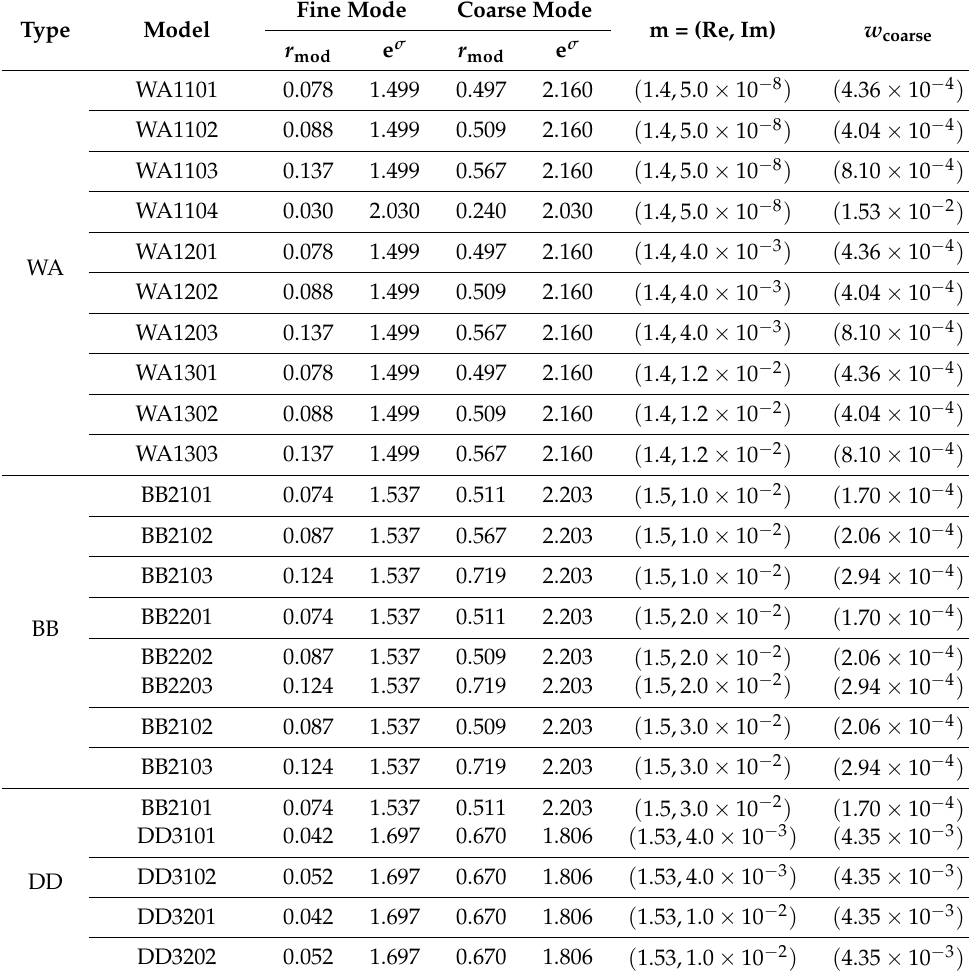
Table 2. Micro-physical properties of aerosols models of Set 2. The median radius of the number size distribution r mod , stand deviation σ , and complex refractive index m of two modes are listed in the table. w coarse is the fraction of coarse mode in number concentration. The two lines of m for MA mod. abs. and MA abs. aerosol model are the refraction index of fine and coarse modes,